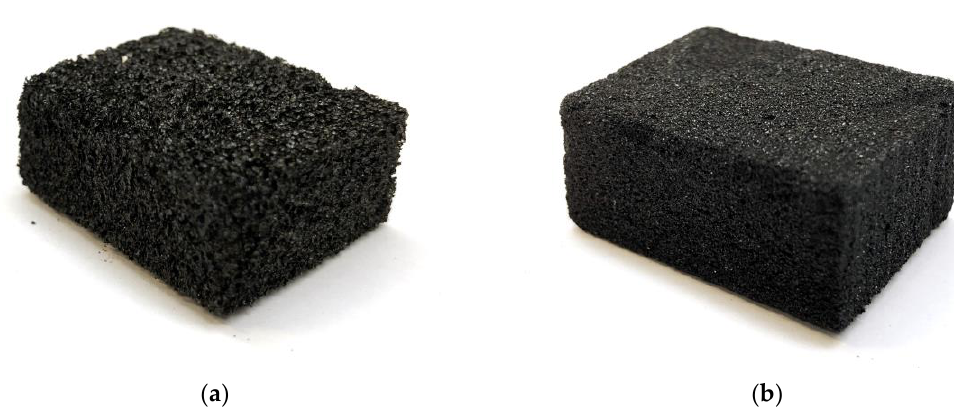
Figure 1. Optical appearance of the standard (SA-DE) ( a ) and high performing petroleum ether (NA-PE) foams ( b ).